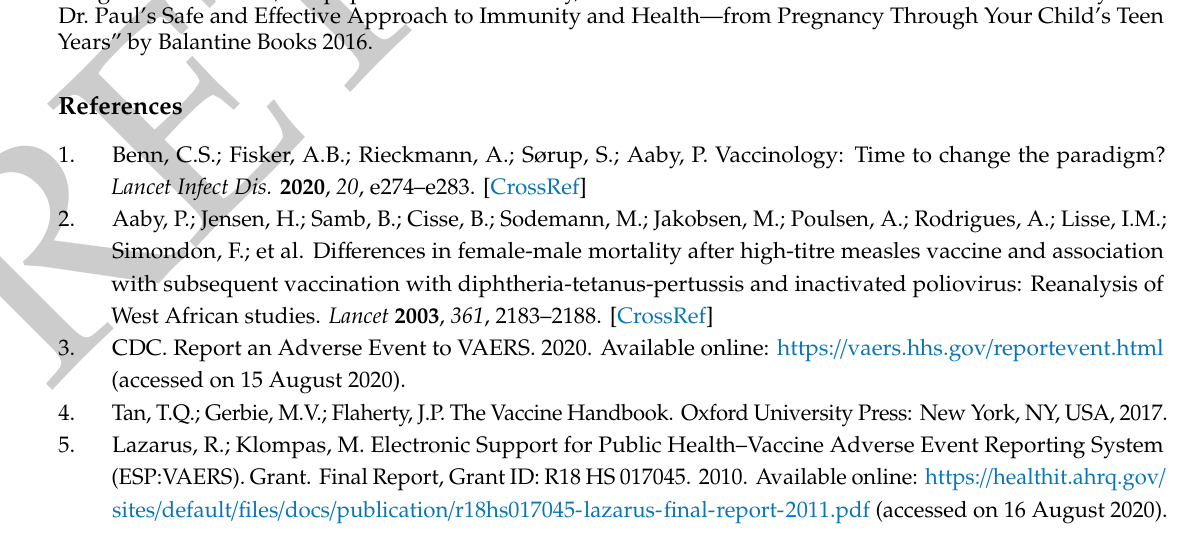
‘Table S1: ICD code mapping’; Table S2: ‘LW and Thomas Supplemental S2 Gender Block Results 2.8.xlsx’; Table S3: ‘LW and Thomas Supplemental S3 Age Blocks